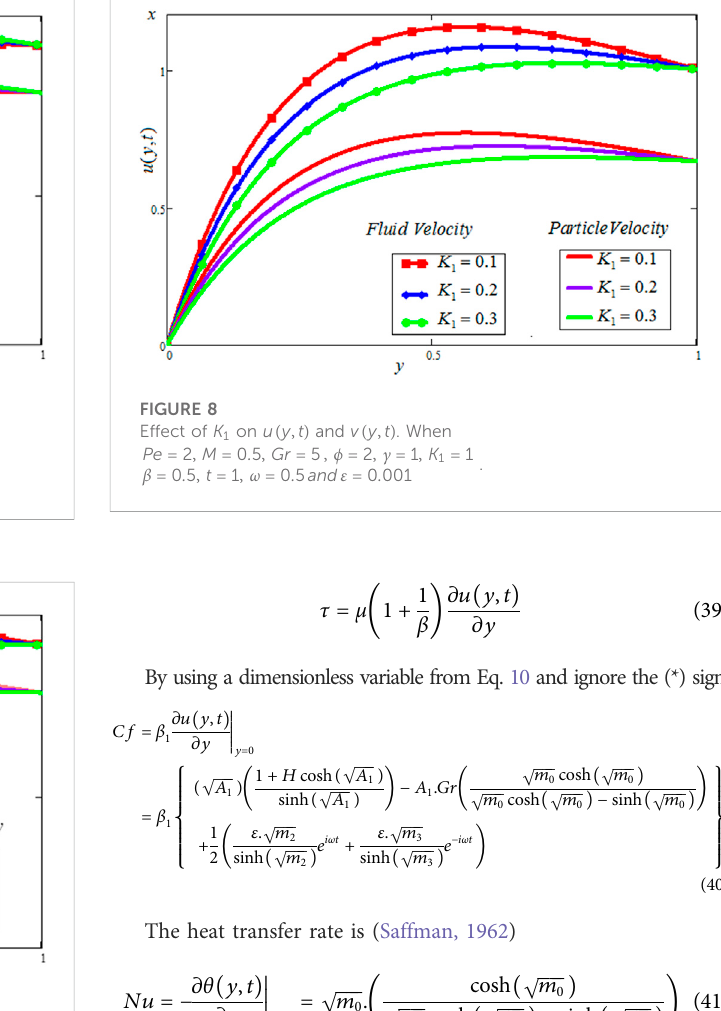
FIGURE 6 Effect of M on u ( y , t ) and v ( y , t ) . When Pe (cid:2) 2 , R (cid:2) 1 , Gr (cid:2) 5 , ϕ (cid:2) 2 , γ (cid:2) 1 , K β (cid:2) 0 . 5 , t (cid:2) 1 , ω (cid:2) 0 . 5 and ε (cid:2) 0 . 001 .